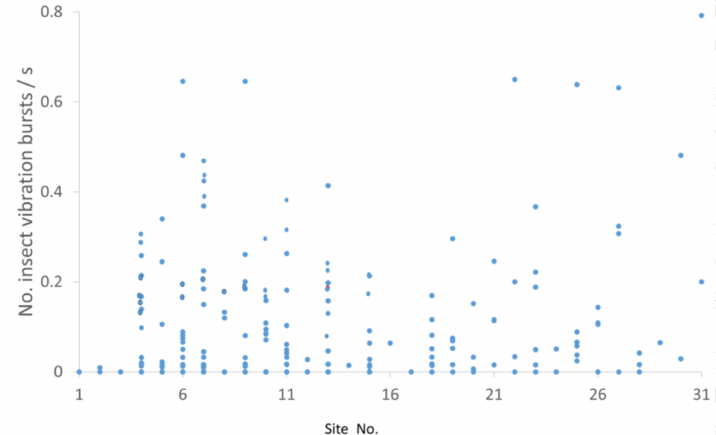
Figure 3. Rates of insect vibration bursts (blue dots) recorded at 31 di ff erent vineyard sites during the